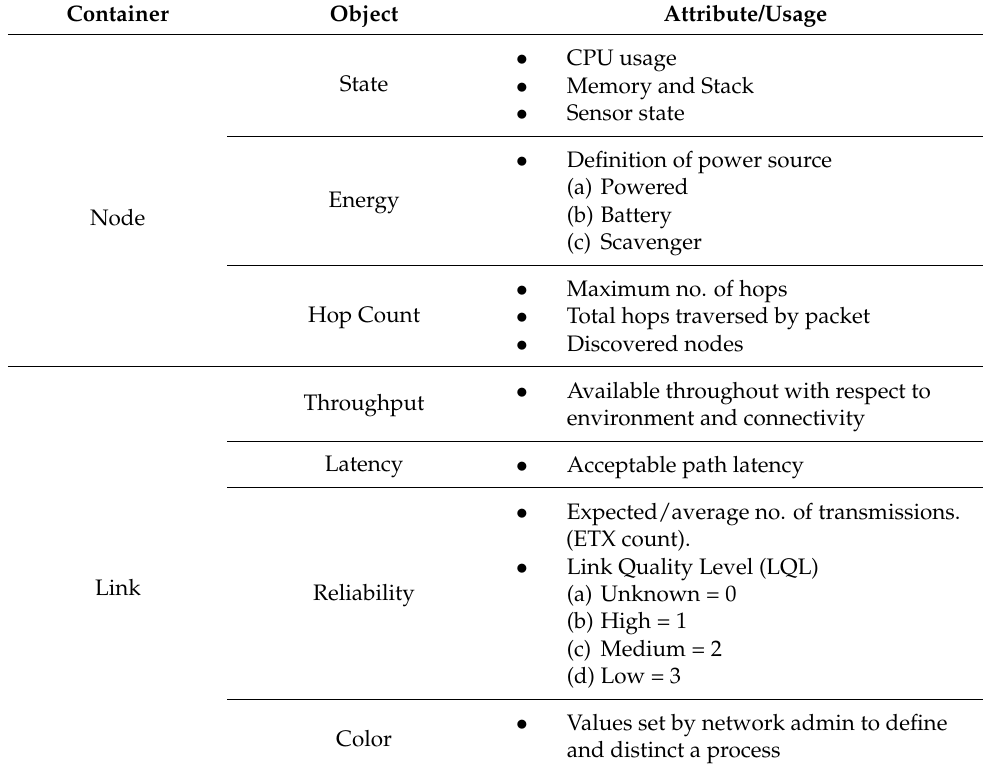
Table 5. DAG connectivity